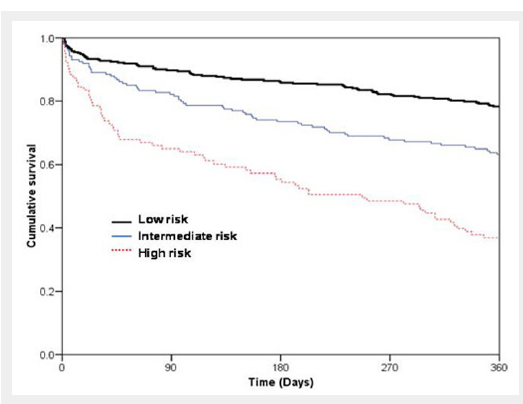
Mortality in patients with AHFD over time according to risk groups: high risk group (BUN >27.5 mg/dl and age >86 years), intermediate risk group (BUN >27.5 mg/dl and age ≤86 years) and low risk group (BUN ≤27.5 mg/dl).